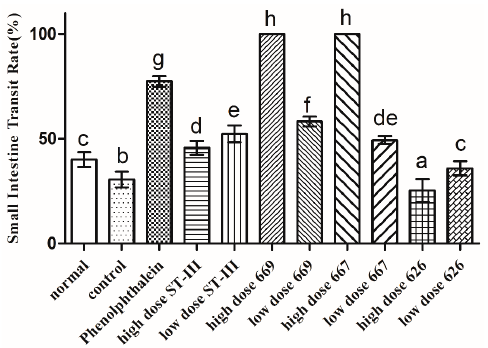
Figure 4. Small intestinal transit rate of mice after constipation was induced by loperamide in eight BALB/c mice in each group. Phenolphthalein: 10 mg/kg body weight; 626: B. adolescentis CCFM 626; 667: B. adolescentis CCFM 667; 669: B. adolescentis CCFM 669; ST-III: L. plantarum ST-III; high dose: 1 × 10 10 CFU; low dose: 1 × 10 8 CFU. Mean values with different letters (a–h) over the bars are significantly different ( p < 0.05) according to Duncan’s multiple range test.